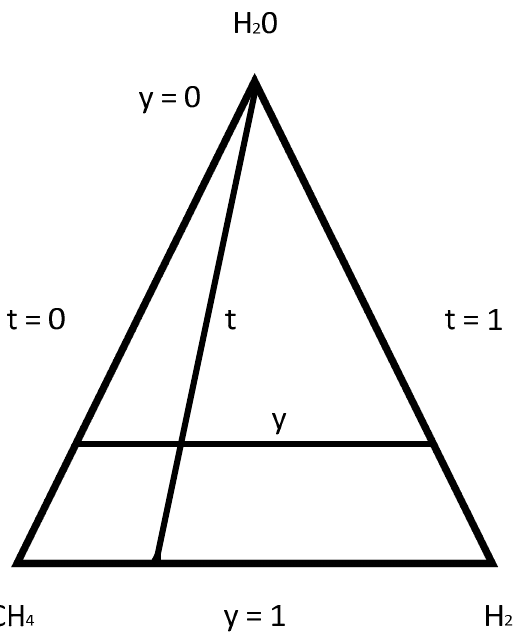
, x 0 , x 0 ) of gaseous mixture (CH 4 /H 2 )–H 2 O as a function of t (cid:2868) , 𝑥 (cid:2868) ) of gaseous mixture (CH (cid:3016)(cid:2868) , 𝑥 H 2 H 2 O CH 4 (cid:3009) (cid:3118) (cid:3004)(cid:3009) (cid:3120) (cid:3118)